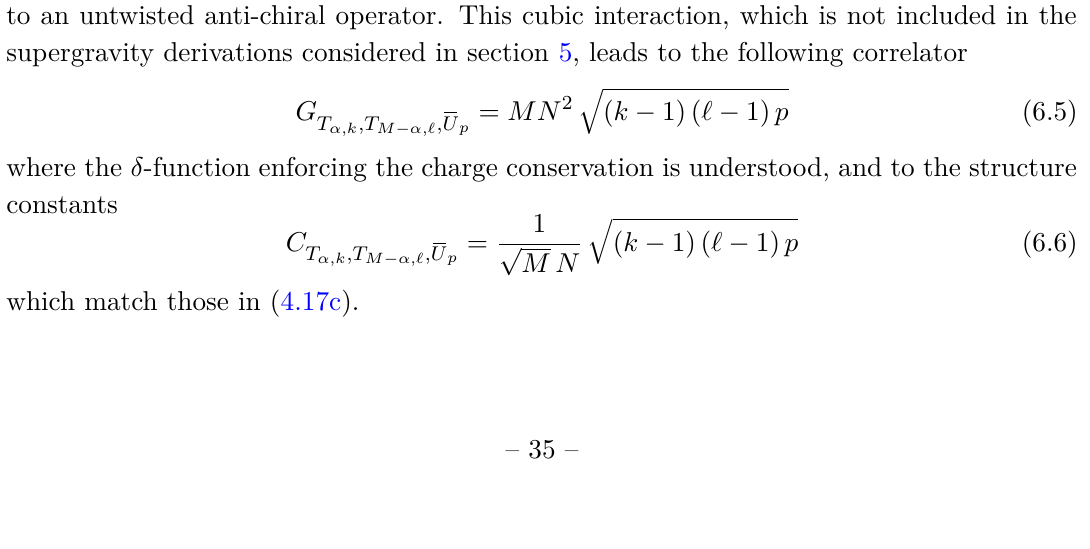
Figure 3 . The 3-point effective Witten-like diagrams that pictorially represent the correlators (6.4). Again the circle, representing the space where the operators are inserted, yields the factor MN 2 , √ p while the cubic vertices in the middle are, respectively, k ‘ p (left) and k ( ‘ − 1) ( p − 1) (right). Notice we have understood the δ which enforces charge k + ‘ − p, 0